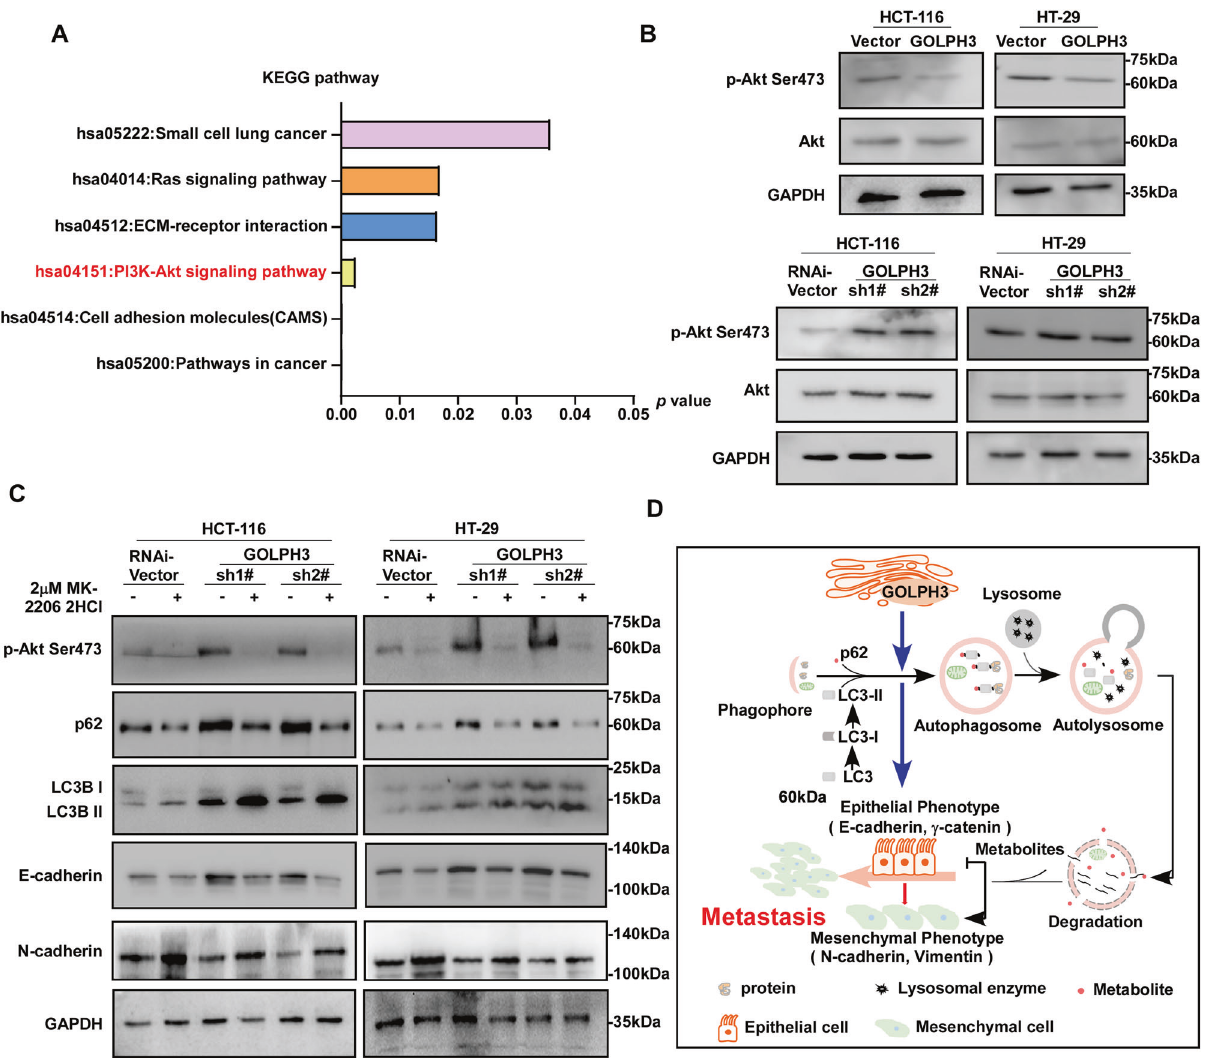
Fig. 7 GOLPH3 facilitates autophagy via the suppression of phosphorylation of Akt at Ser473. A KEGG (Kyoto Encyclopedia of Genes and Genomes) analyses differentially expressed genes between the HCT-116-PMSCE-Vector and HCT-116-PMSCV-GOLPH3 cells. B Western blot analysis of GOLPH3-overexpressing and control HCT-116 and HT-29 cell lines. Akt Ser473 phosphorylation was decreased in GOLPH3- overexpressing cells. In GOLPH3-silenced colorectal cancer cells, Akt Ser473 phosphorylation was enhanced. C MK-2206 2HCl was used to repress Akt phosphorylation. P62 and E-cadherin were stimulated, and N-cadherin was repressed when GOLPH3 was silenced. When CRC cell lines were cultured in Akt Ser473 phosphorylation inhibitor, P62 and E-cadherin were repressed, and N-cadherin was enhanced. GAPDH was used as an internal reference. D The above results demonstrated that GOLPH3 induces autophagy and EMT to promote metastasis in colon cancer, via the repression of Akt Ser473 Western blotting analysis The colon cancer cells were lysed using cooled radioimmunoprecipitation assay (RIPA) lysis buffer. Proteins were extracted following a standard protocol, and their concentration was measured using a bicinchoninic acid